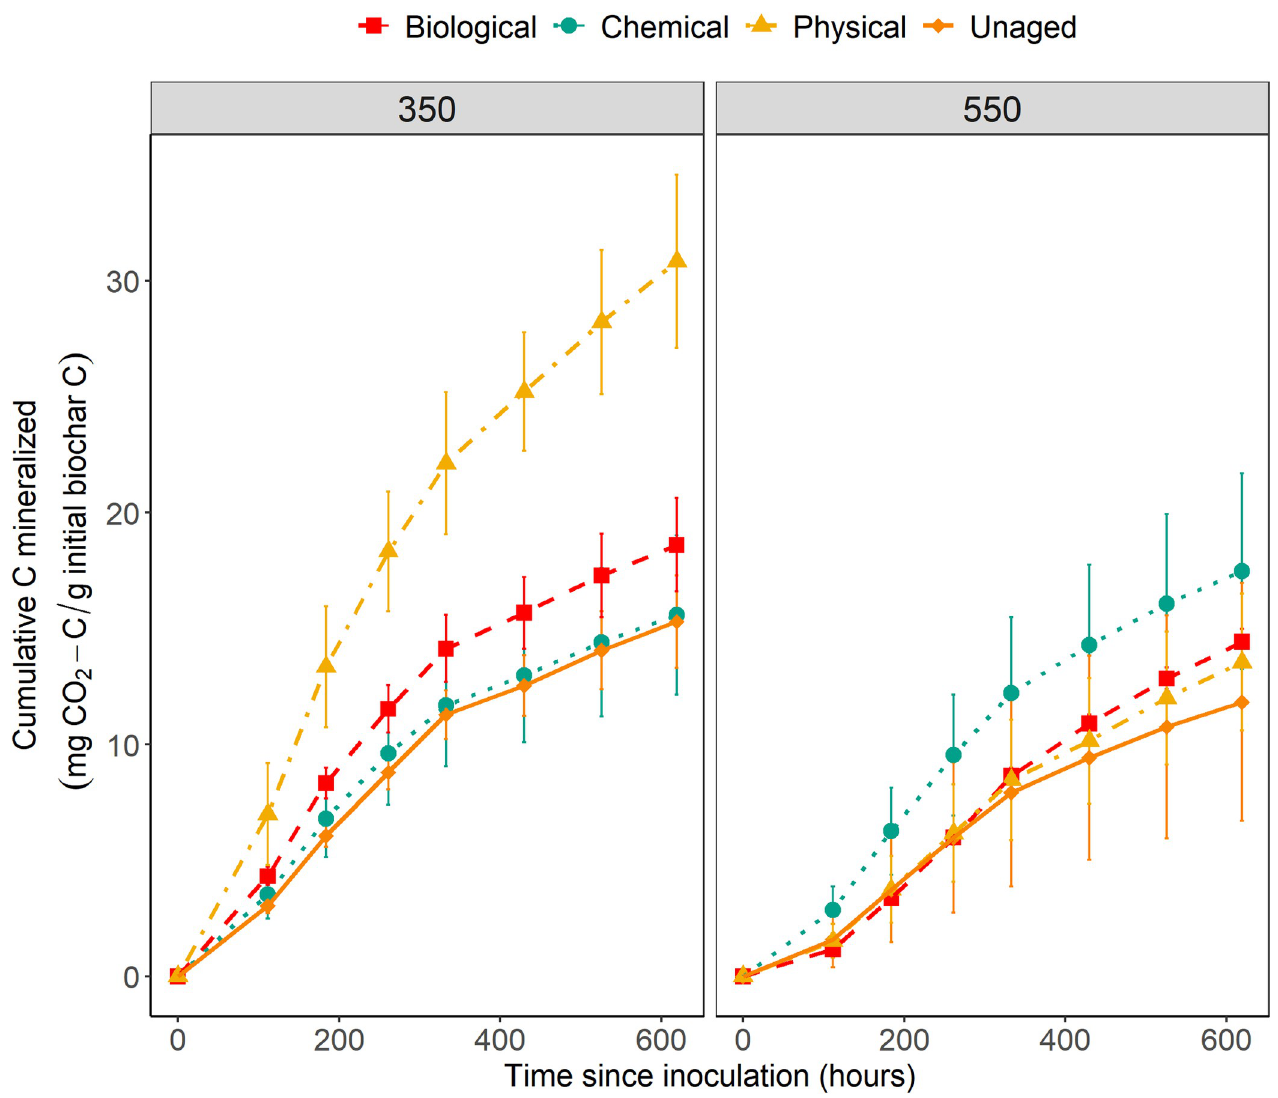
Fig 1. Cumulative biochar C mineralization over time. Data represent mean cumulative C mineralized from unaged and physically, chemically and biologically aged biochar samples over time, with uninoculated blanks subtracted and normalized with mean biochar-C. N = 3 for physical, chemical and unaged, N = 5 for biological. Error bars represent 95% confidence intervals. The left panel shows biochar produced at 350˚C and the right panel shows biochar produced at 550˚C.